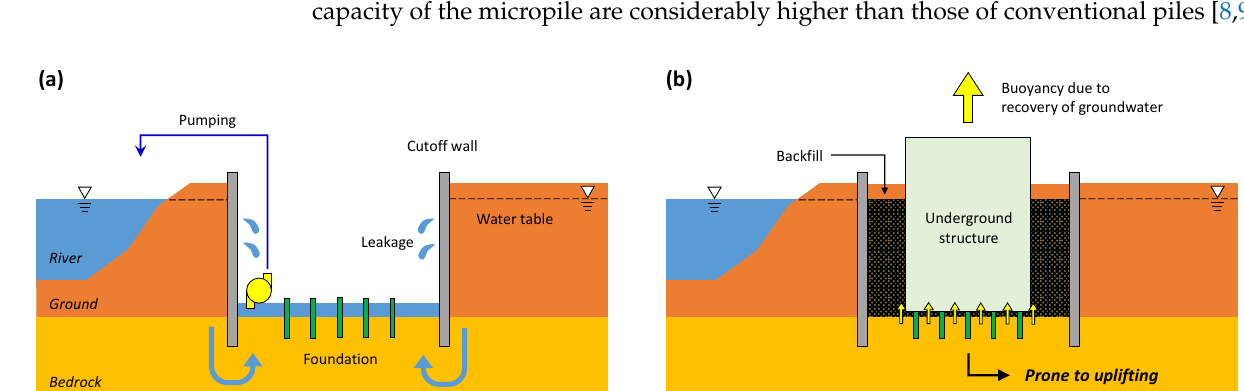
Figure 1. Uplifting mechanism of foundation systems adjacent to a river channel. ( a ) Underground construction inducing seepage into the construction space, and ( b ) buoyancy of the structure is induced after backfilling due to recovery of ground water. This mechanism causes an uplifting force to act on the foundations.